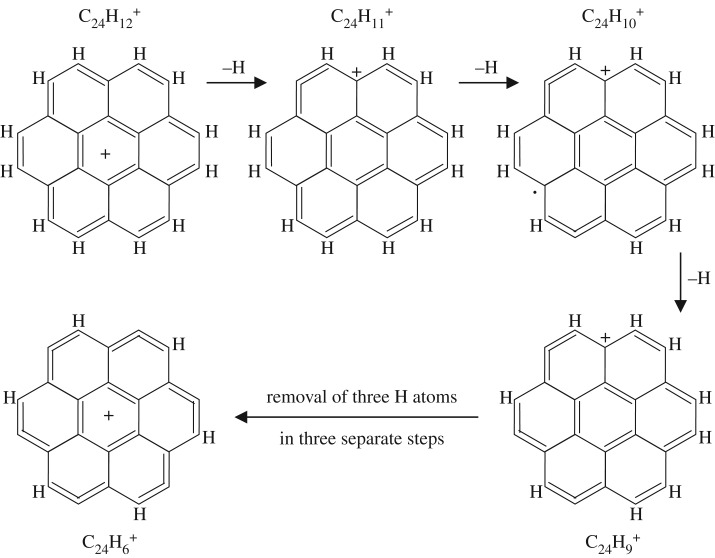
One possible pathway for the dehydrogenation of the C24H 12+ (S7) coronene cation to C24H 6+.